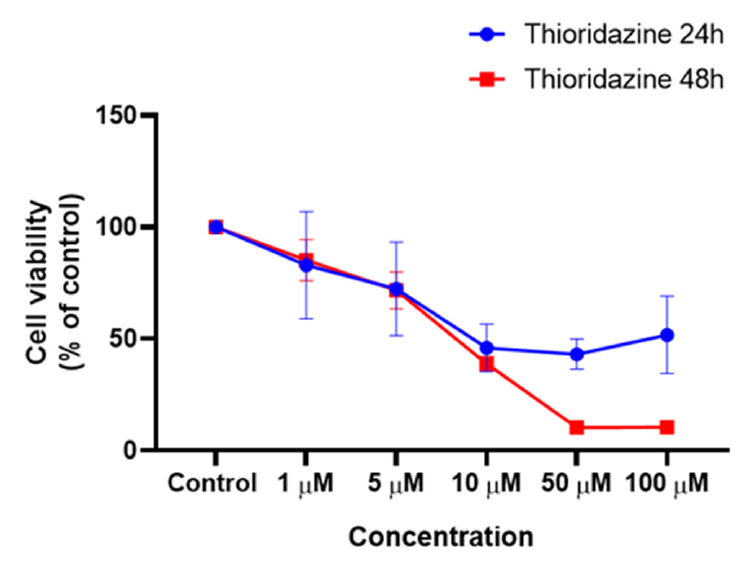
Figure 13. Comparison of the cell viability (% of control) between 24 h and 48 h of exposure. Results are expressed as mean ± standard error of the mean (SEM).